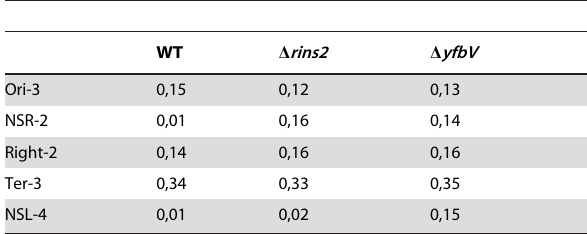
Table 2. Co-localisation index of chromosomal